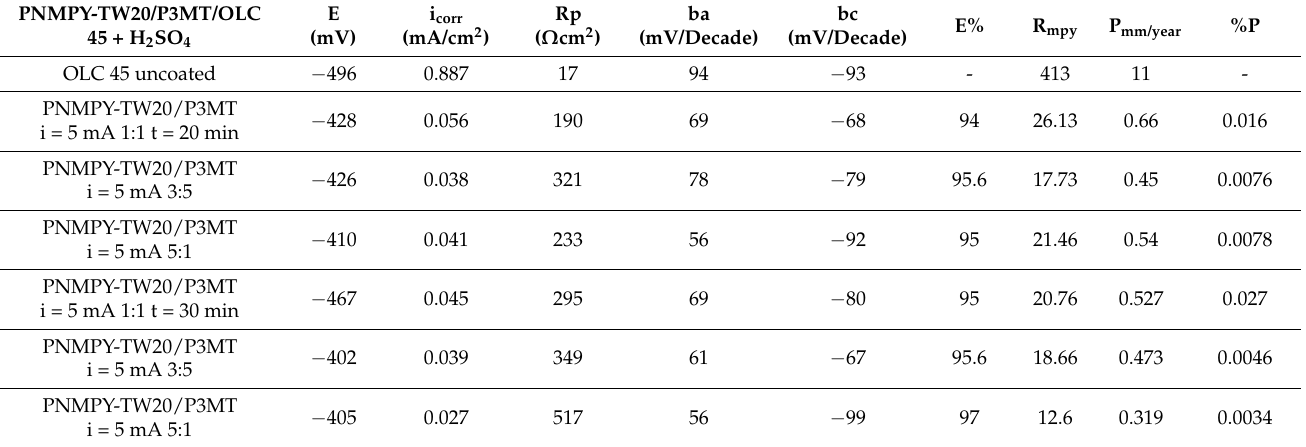
Table 2. Kinetic corrosion parameters of coated and uncoated OLC 45 sample in 0.5 M H 2 SO 4 solution at 25 ◦ C.